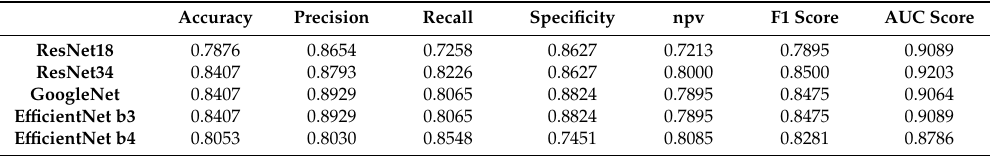
Table 2. Prediction performance on hip radiographic-image data only.